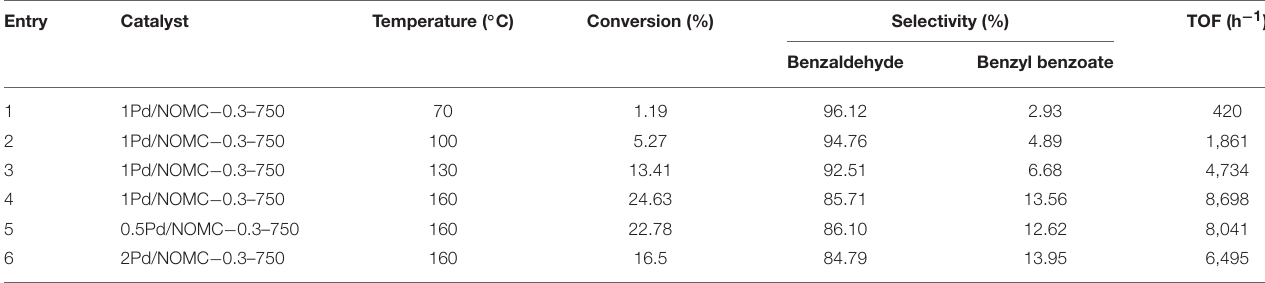
TABLE 3 | Catalytic properties of Pd-containing catalysts supported on NOMC-0.3–750 a .